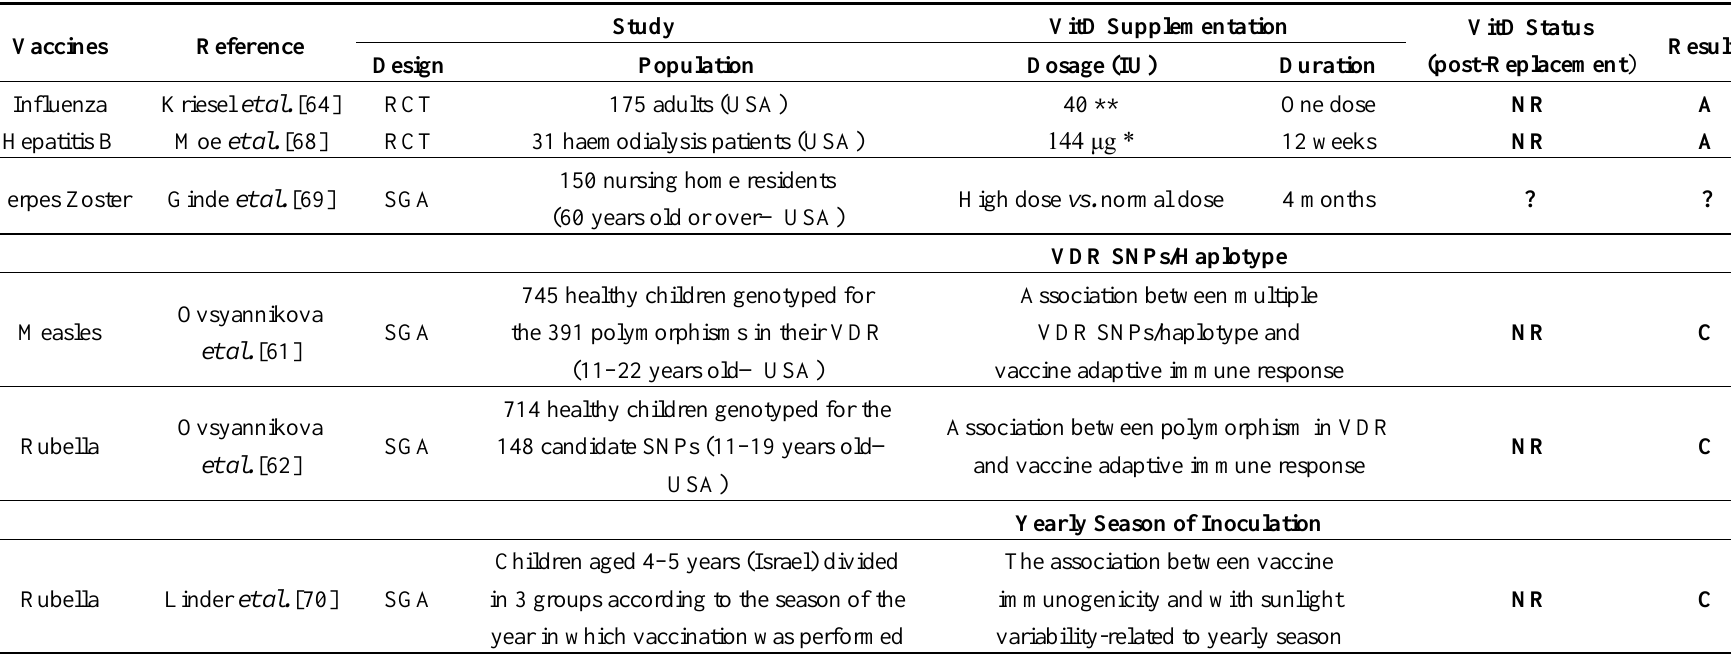
Table 1. Summary of clinical trials and observational studies evaluating the influence of VitD serum level and multiple VDR single nucleotide polymorphisms (SNP/haplotype) on the vaccine immunogenicity in